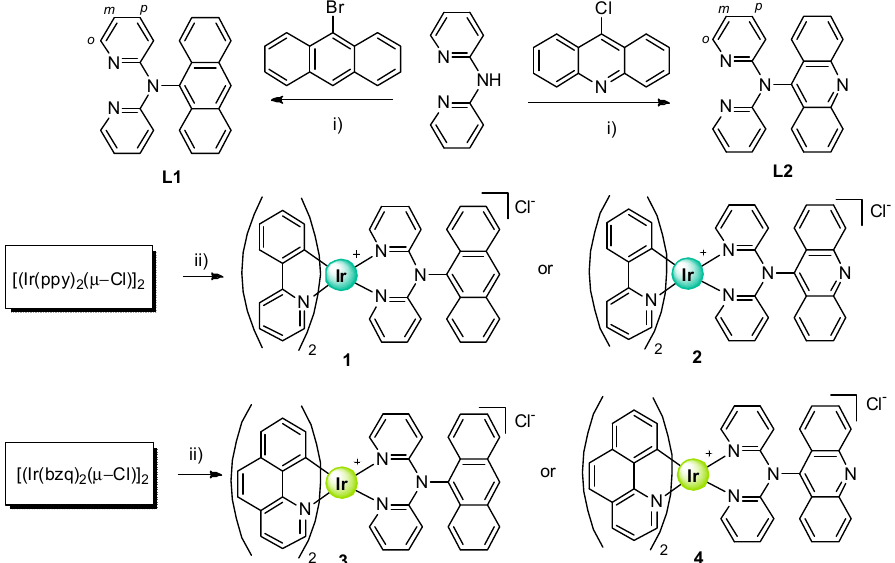
Scheme 1. Synthetic pathway for the synthesis of L1 and L2 and complexes 1 – 4 . Reaction condi-